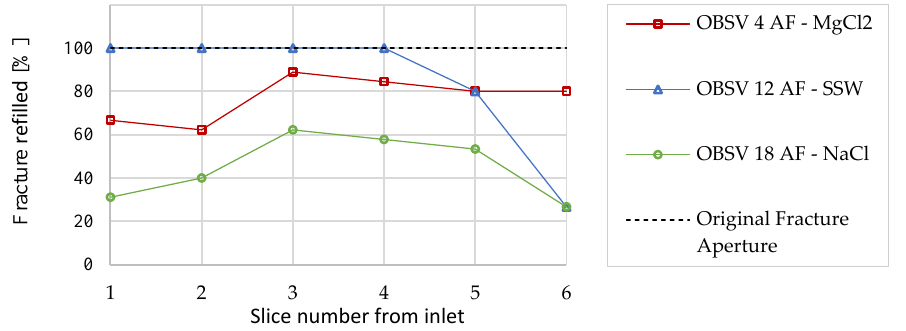
Figure 7. Distribution of artificially fractured aperture diameter reduction (mm) for the three fractured samples from inlet to outlet.